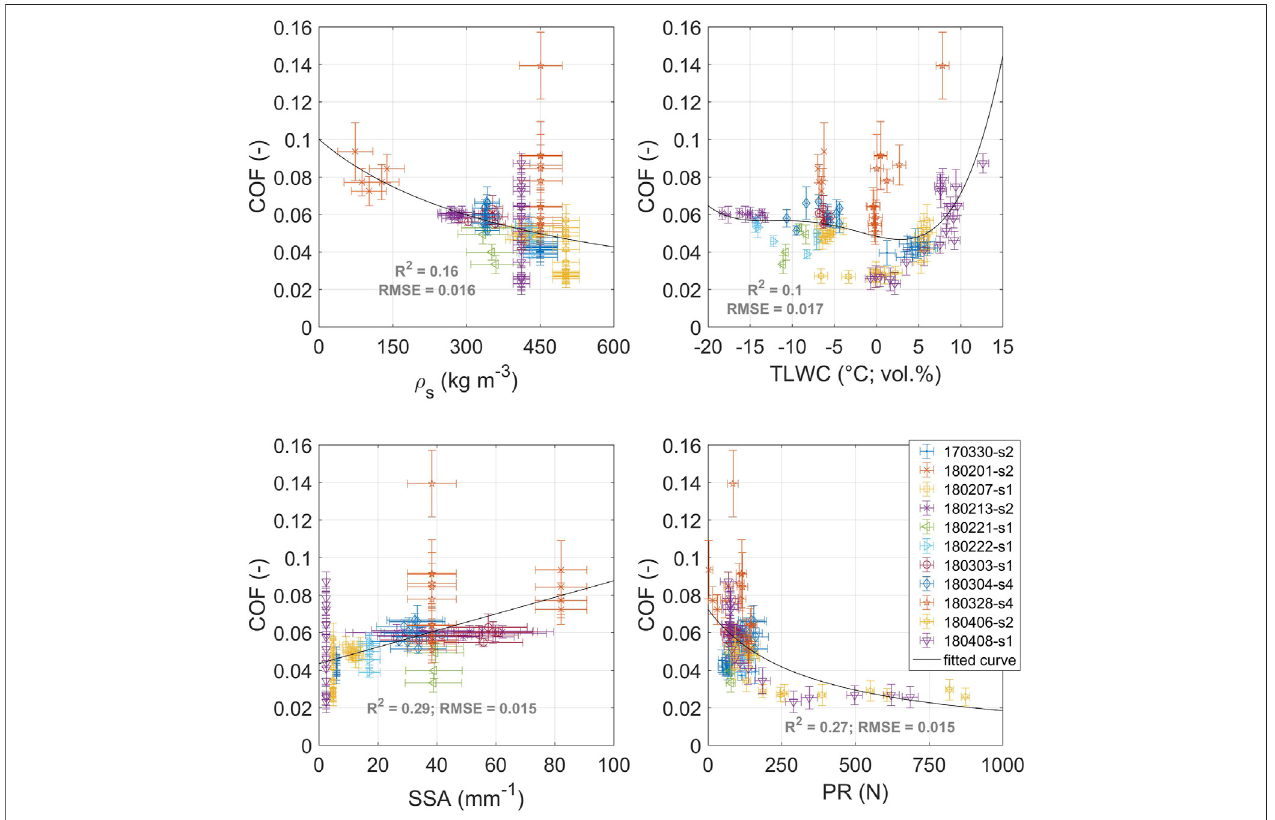
FIGURE6| Mean ( ± σ ) friction coef fi cients ofall analyzed ( n (cid:1) 114)ski runsplottedversus thecorrespondingapproximated snow properties ( ± RMSE) at thetime of each run. Fitted curves represent single snow parameter models speci fi ed in the methods.